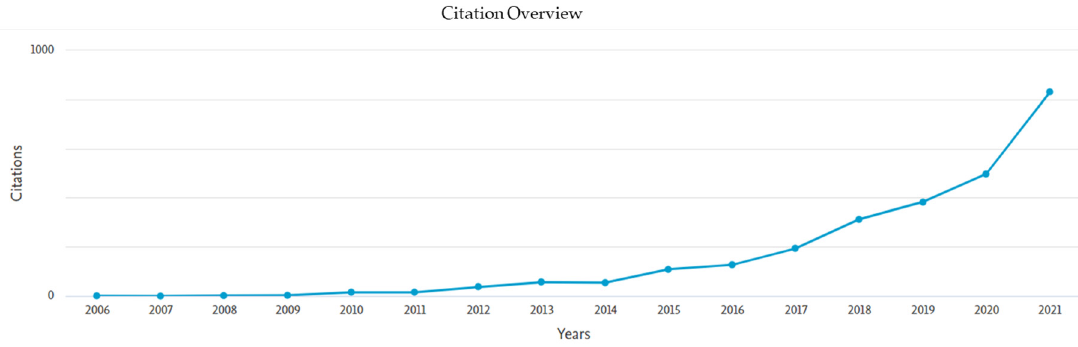
Figure 2. Citation overview of the selected papers related to MT-InSAR for infrastructure monitoring.